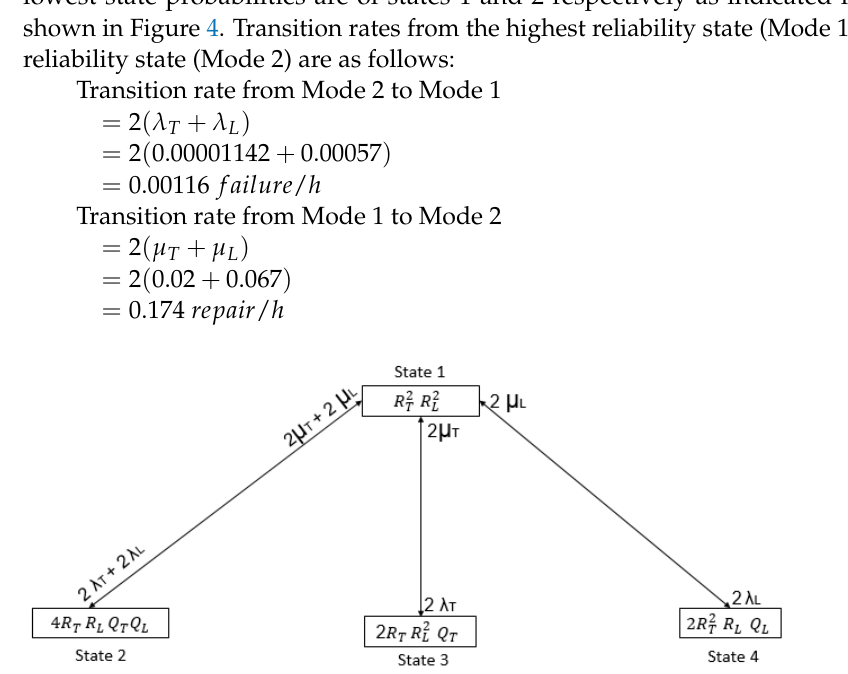
Figure 4. Four-operable (successful or UP) states Markov model. The state-space diagram for the two states is shown in Figure